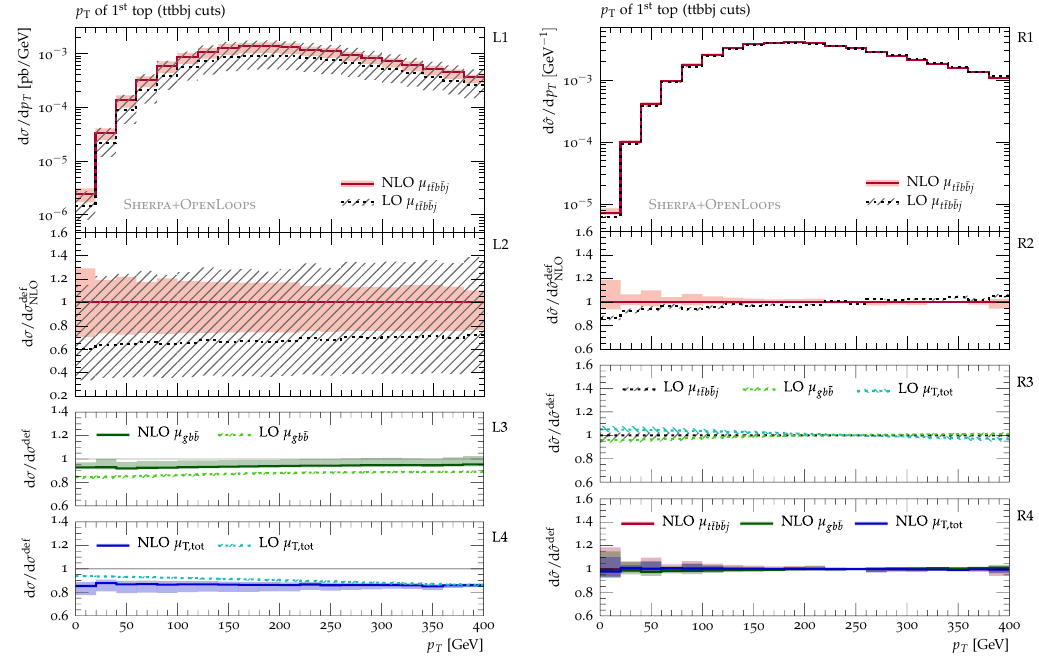
Figure 11. p T of the harder top. Same setup and plots as in (cid:12)gure 8.